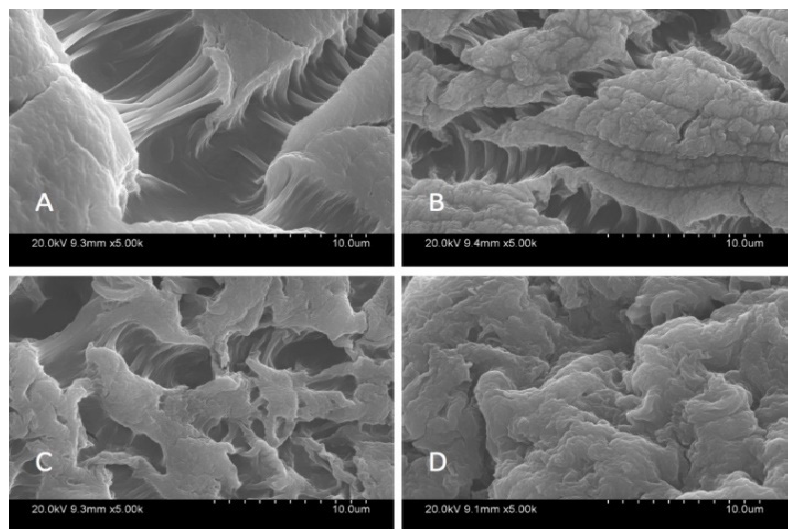
Figure 2. SEM images of beads at 5000×; Ca-Alg2 ( A ), Ca-Alg2/GO5 ( B ), Ca-Alg2/GO10 ( C ), Ca- Alg2/GO20 ( D ).